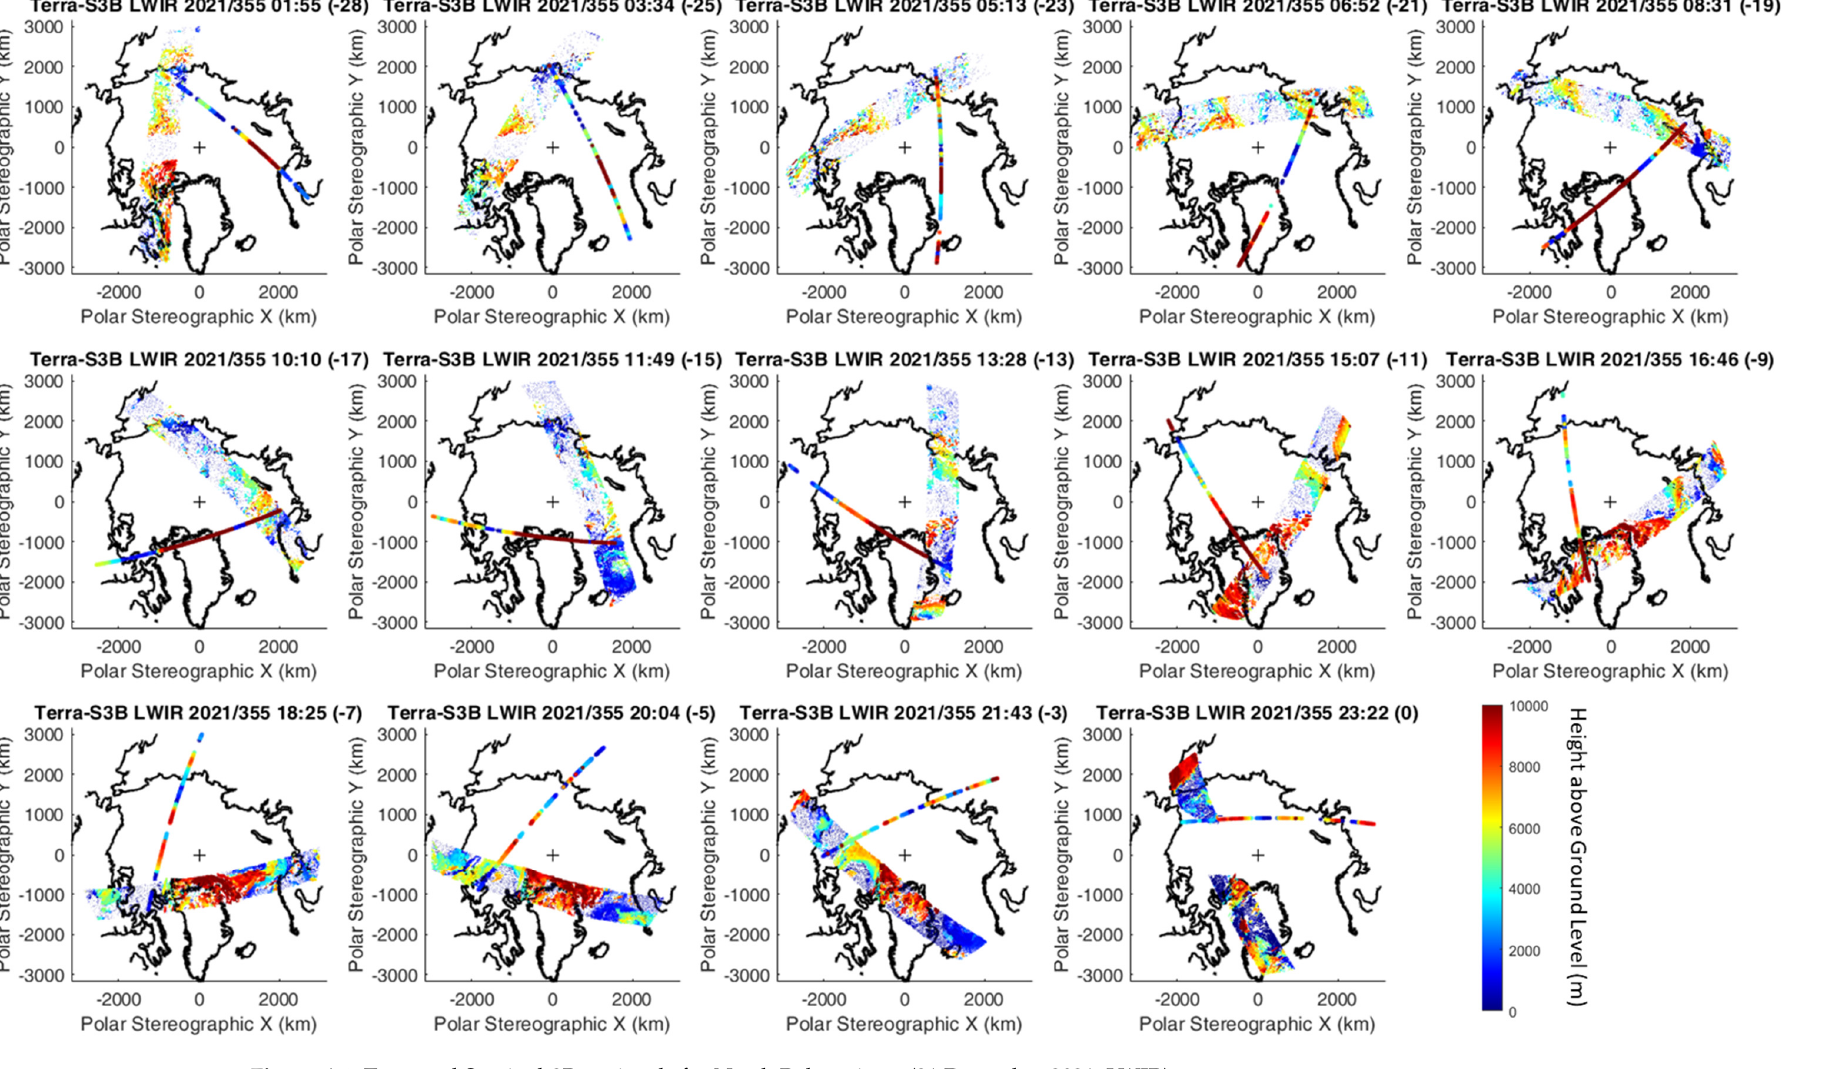
Figure A4. Terra and Sentinel-3B retrievals for North Polar winter (21 December 2021, LWIR).